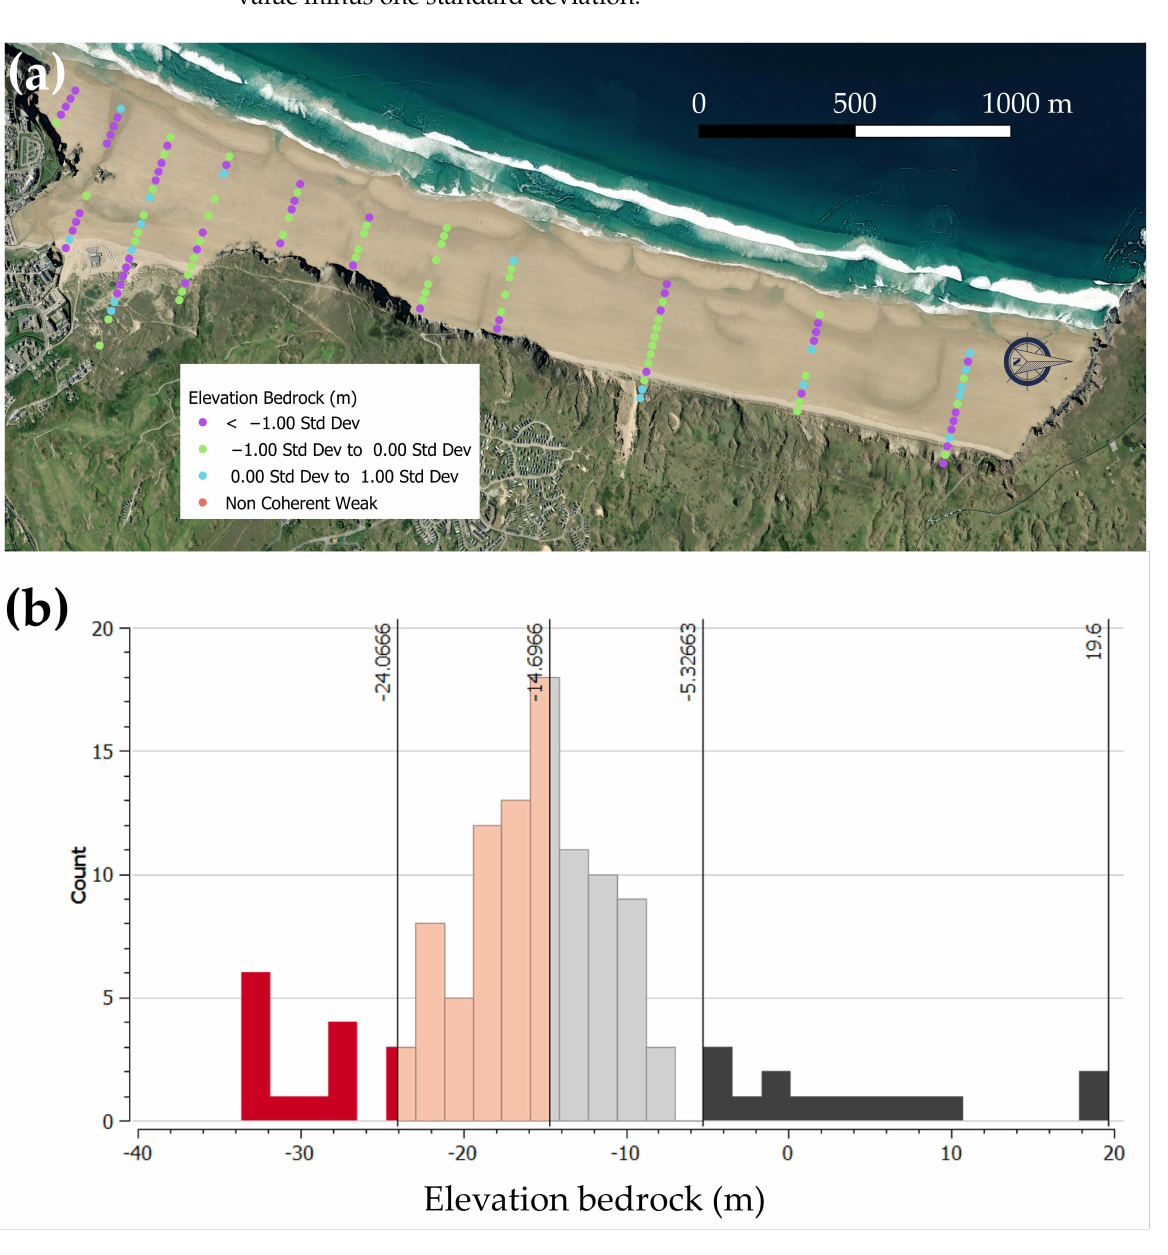
Figure 12. Elevation of the bedrock spatial ( a ) and frequency distribution ( b ) obtained from the PSS sampled at Perranporth Beach. The vertical lines in ( b ) represents the max and min value for each colour